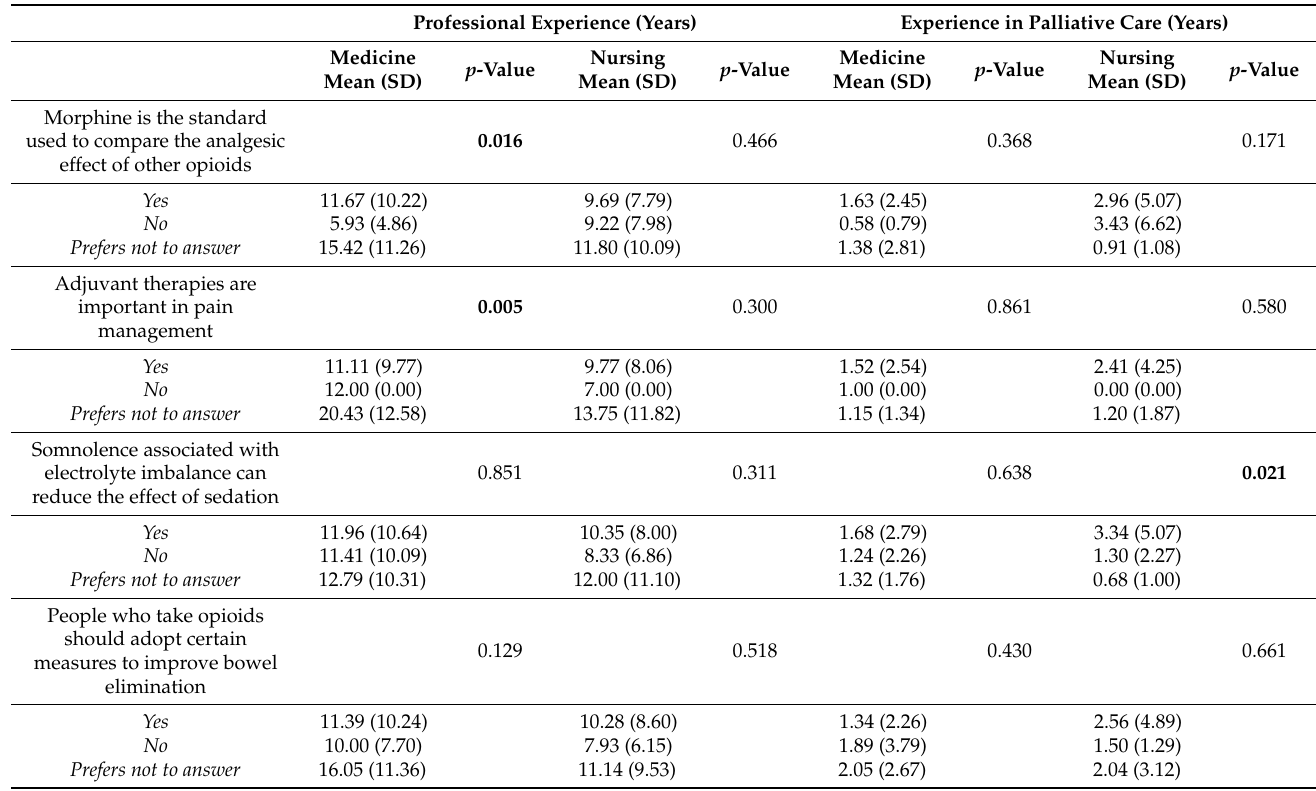
Table 6. Physicians’ and nurses’ knowledge according to general professional experience and experience in palliative care.